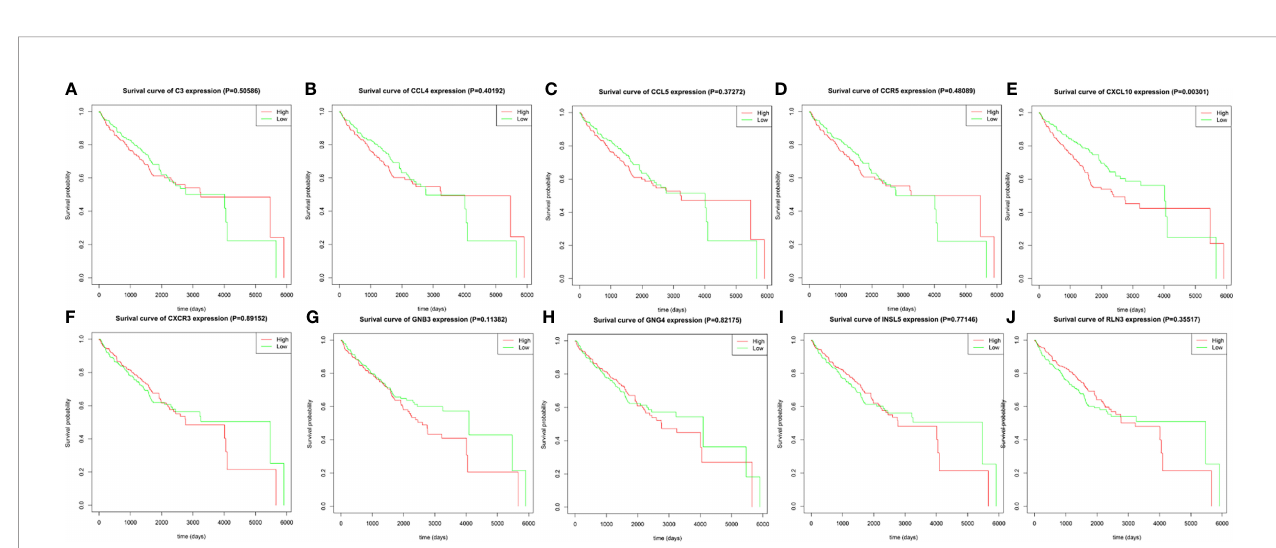
FIGURE 8 | The prognostic value of the ten identi fi ed hub genes for overall survival of patients with ccRCC. (A) Kaplan – Meier plot for C3, p = 0.50586; (B) Kaplan – Meier plot for CCL4, p = 0.40192; (C) Kaplan – Meier plot for CCL5, p = 0.37272; (D) Kaplan – Meier plot for CCR5, p = 0.48089; (E) Kaplan – Meier plot for CXCL10, p = 0.00301; (F) CXCR3, p = 0.89152; (G) Kaplan – Meier plot for GNB3, p = 0.11382 (H) Kaplan – Meier plot for GNG4, p = 0.82175; (I) Kaplan – Meier plot for INSL5, p = 0.77146; (J) Kaplan – Meier plot for RLN3, p = 0.35517. A value of p < 0.05 was considered statistically signi fi